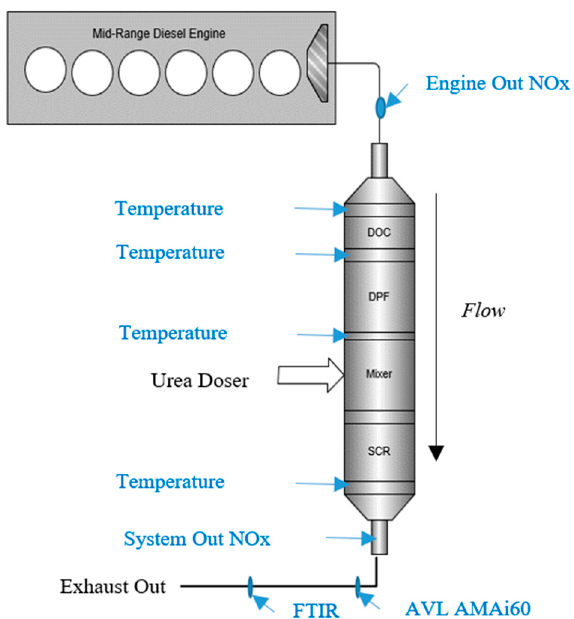
Figure 1. Aftertreatment architecture and test setup scheme.